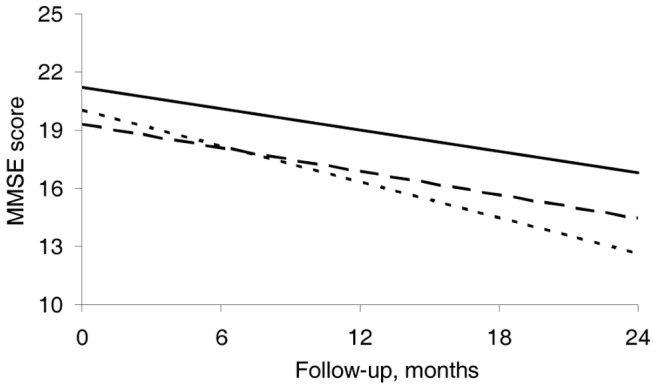
Predicted trajectories of MMSE score according to tertiles of CSF phosphorylated PKR.Mixed model is adjusted for age, sex, tertiles of CSF pPKR and their interactions with time in months. Solid line: lower tertile of pPKR (0–65 ODU), long-dashed sline: middle tertile of pPKR (65–100 ODU), short-dashed line : upper tertile of pPKR (>100 ODU). Cognitive decline is more pronounced in patients with high levels of CSF pPKR (short-dashed line).